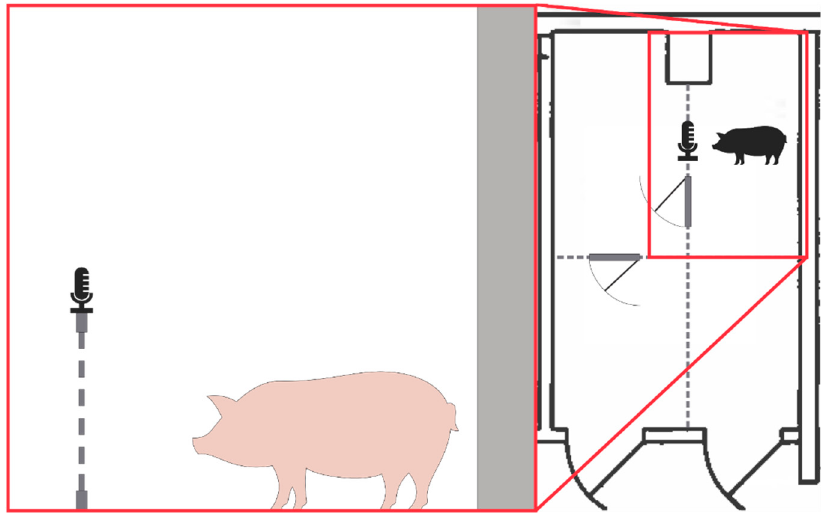
Figure 1. Schematic illustration of the pig recording environment. From the recorded audio material, 95 normal squeals (collected before surgery) and 143 abnormal squeals (collected after surgery) were manually extracted. Vocalizations were identified as squeals based on the following criteria: duration of sound at least 0.3 s, no overlapping vocalizations, and high subjective pitch. Starting and ending positions of each squeal were determined by plotting the relevant acoustic signal sections in Matlab